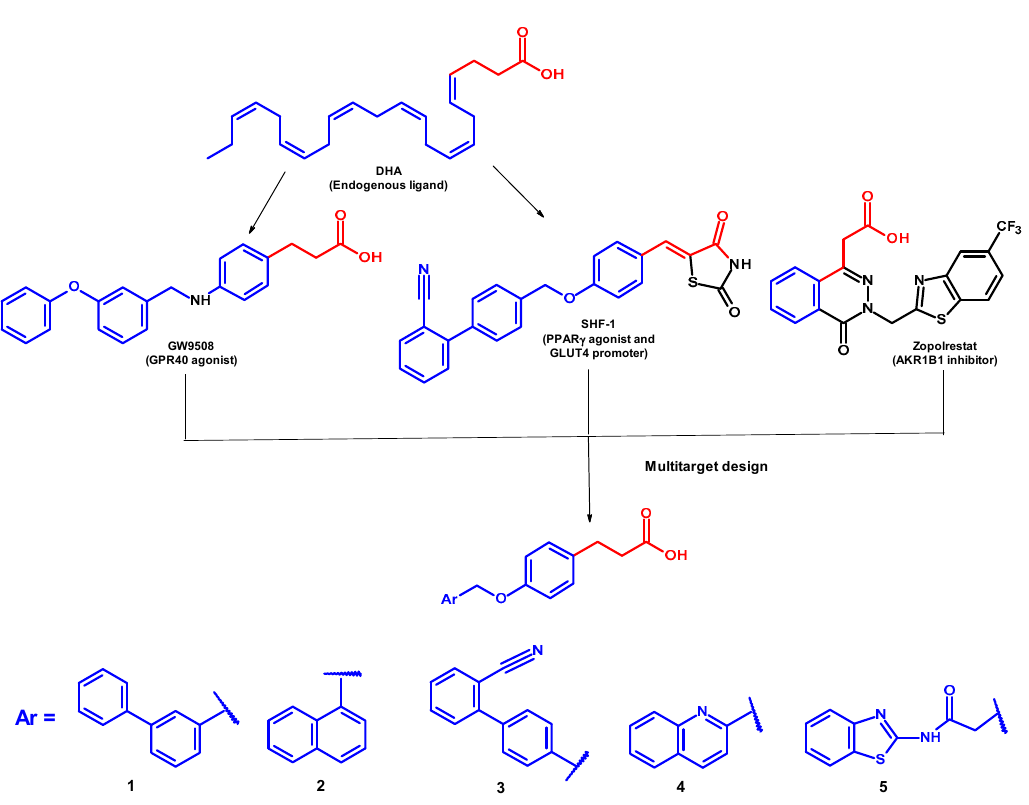
Figure 1. Drug design of multitarget compounds 1 – 5 , which were designed from pharmacophore extraction and reorganization from known modulators of four targets: GPR40, PPAR γ , GLUT-4, and AKR1B1.